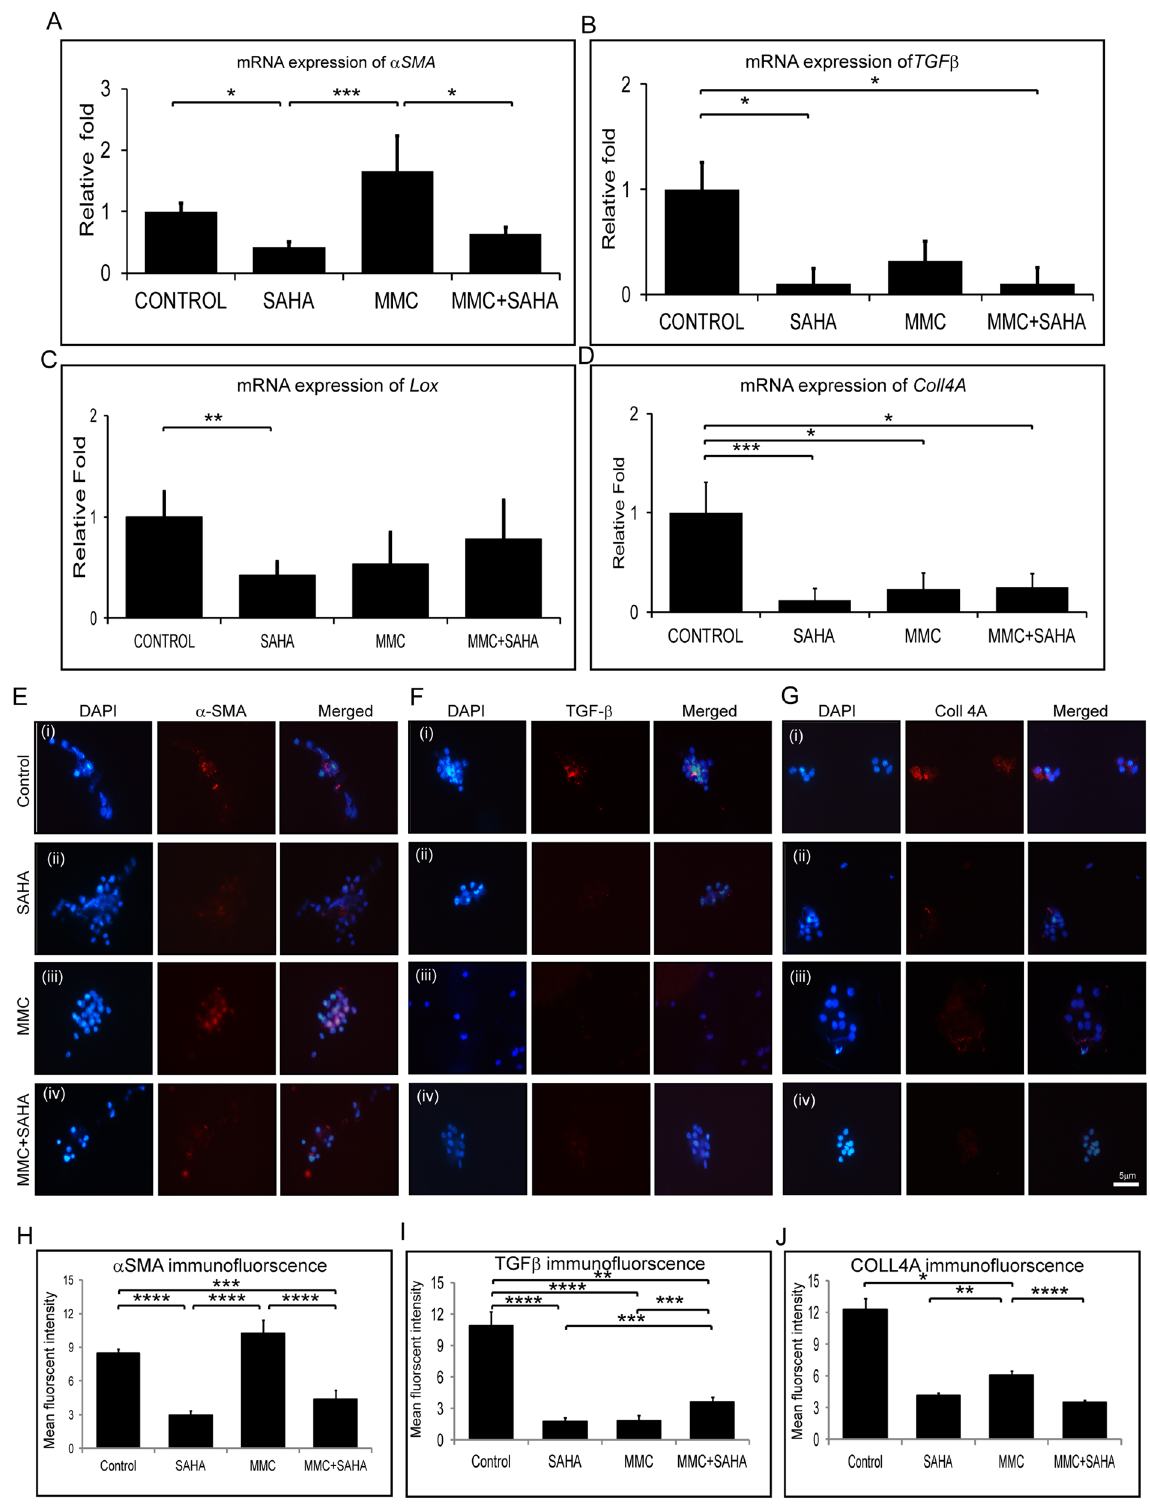
Figure 5. Effect of MMC and SAHA on fibrotic markers. Relative mRNA expression levels of αSMA ( A ), Tgfβ ( B ), Lox ( C ) and Coll4A ( D ) in cells obtained from study group 2 and control (n = 4). Representative immunofluorescence images with αSMA (red) ( E ), TGFβ (red) ( F ), COLL4A (red) ( G ) and DAPI (blue) in cells obtained from corneal rims of study group 2 (n = 4). Immunofluorescence experiments were conducted in triplicate and the mean fluorescent intensity was calculated for 200–220 cells and depicted graphically stained with αSMA ( H ), TGFβ ( I ), COLL4A ( J ). Statistical significance based on one way ANOVA test denoted by *p ≤ 0.05, **p ≤ 0.01, ***p ≤ 0.001, ****p ≤ 0.0001 was calculated in presence of SAHA and MMC in comparison to untreated cultured cells. Images